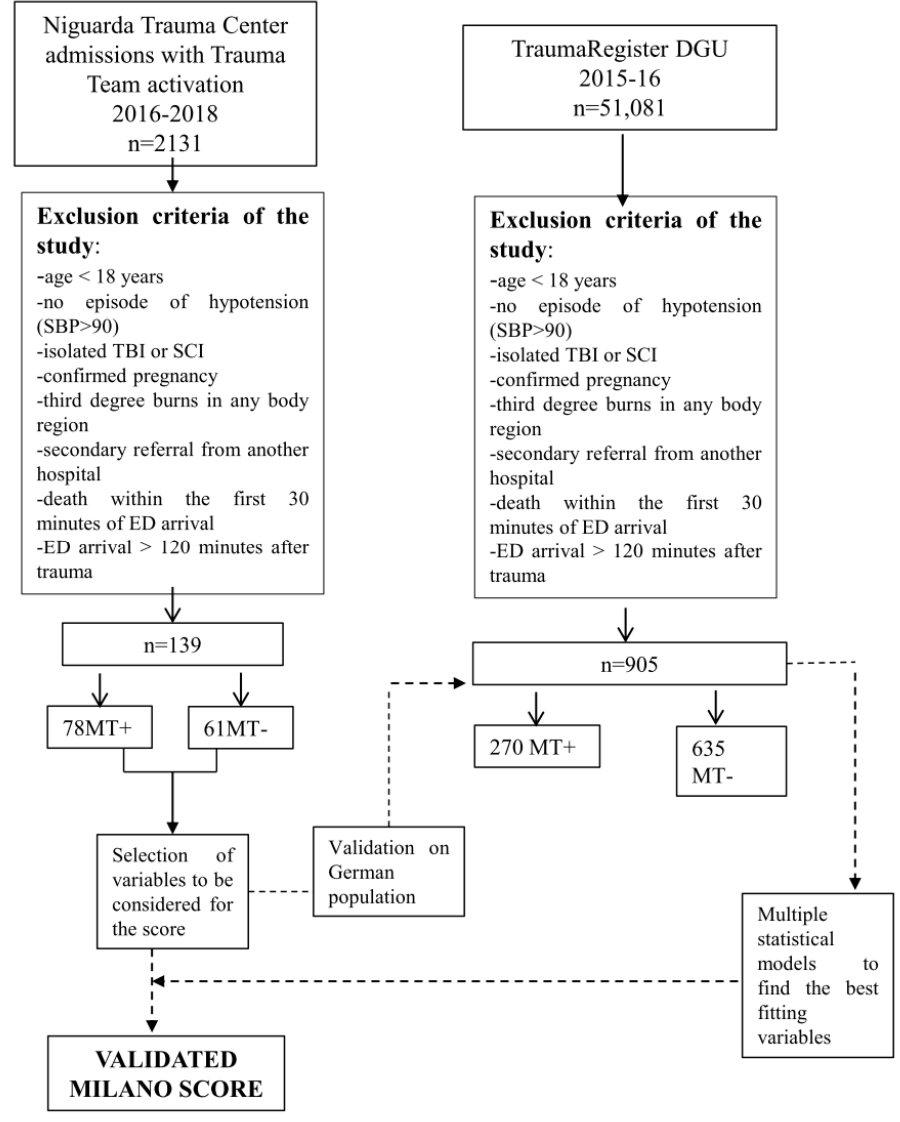
Figure 1. Cohort characteristics and process of validation of the Milano score. The figure describes the steps followed to obtain the validated Milano score. ED: emergency department; MT: massive transfusion; SCI: spinal cord injury; TBI: traumatic brain injury. The modified score (Figure 2) with a maximum value of 9 obtained an area under the ROC of 0.738. This final score, called Milano score, was finally re-applicated on the original Italian dataset obtaining a larger AUC, with a value of 0.854. Probability of MT was 85.4% with a score ≥ 4 and 100% with a score ≥